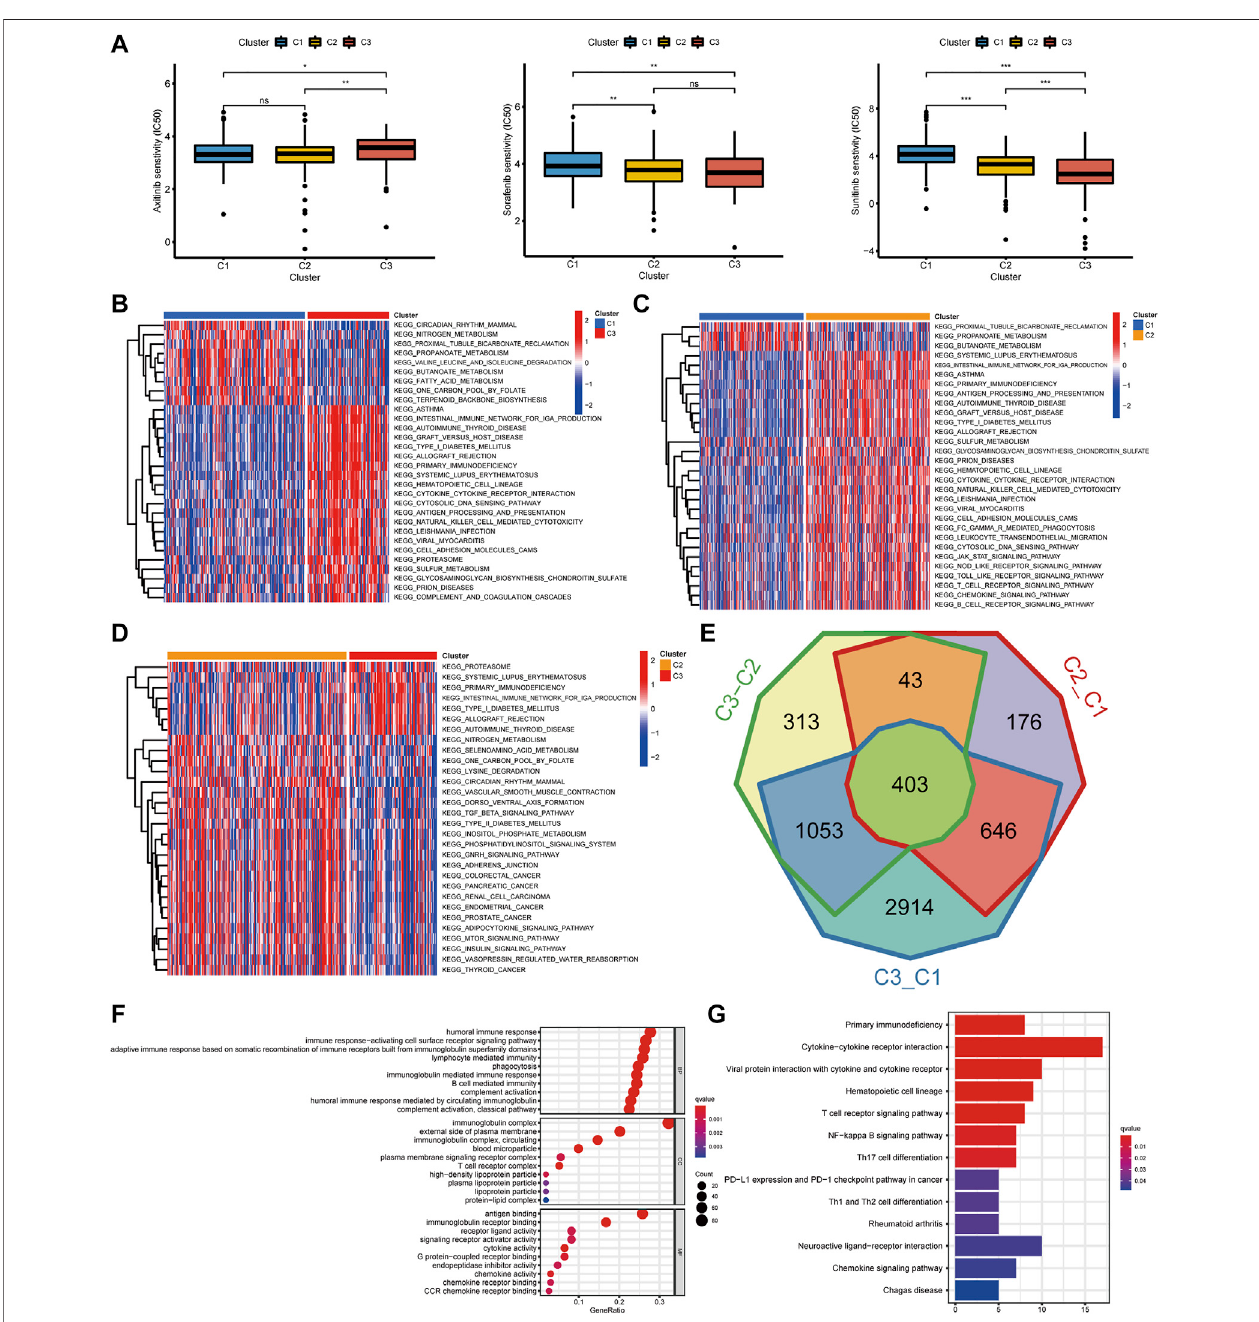
FIGURE3| Theinteraction andcorrelation amongthepyroptosissubtypes. (A) ThedifferentIC50 oftargeted drugsinthethreepyroptosissubtypes. (B – D) GSVA enrichment analysis presents the activation states of biological pathways in the three pyroptosis subtypes. The heatmaps were utilized to visualize the biological processes. Red and blue, respectively, represented the activated and inhibited pathways. (E) A Venn diagram revealed the common differential genes of the three pyroptosis subtypes. (F,G) GO and KEGG analysis of DEGs in the three pyroptosis subtypes (*** p < 0.001, ** p < 0.01, * p < 0.05).